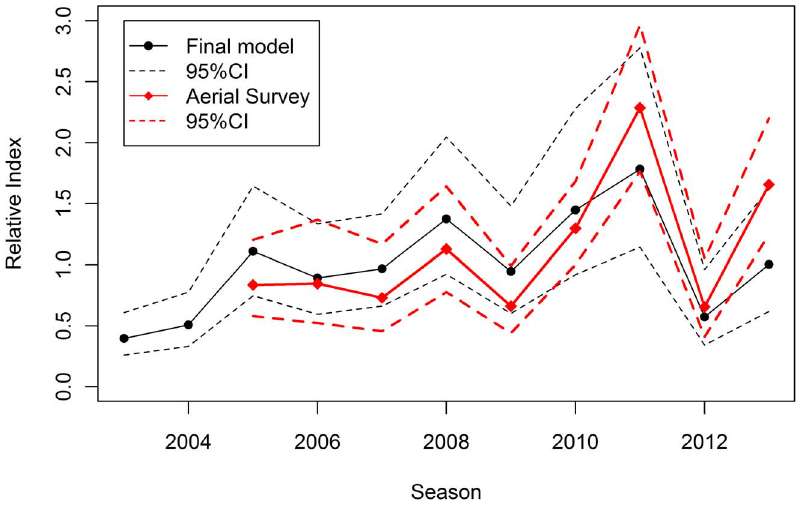
Fig. 5. Comparison of standardised index and line-transect aerial survey index taken from Eveson et al. (2013). The standardised index from the final model as in Figure 4 compared to the line-transect aerial survey index (scaled to the commercial index mean over 2005–2013); 95% confidence interval s for each index are also